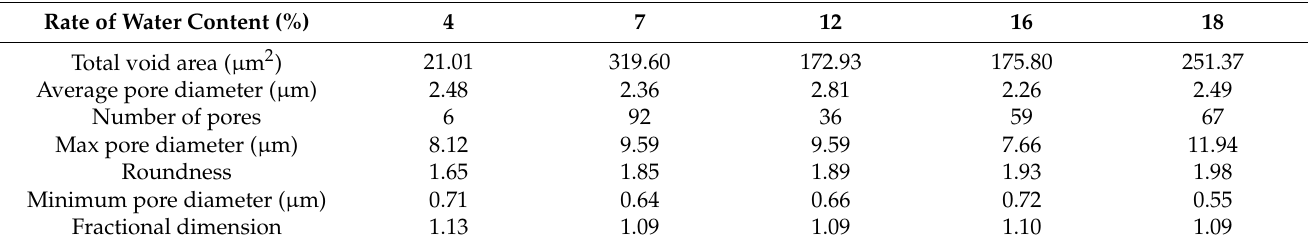
Table 2. Pore structure parameters of N-1 mudstone